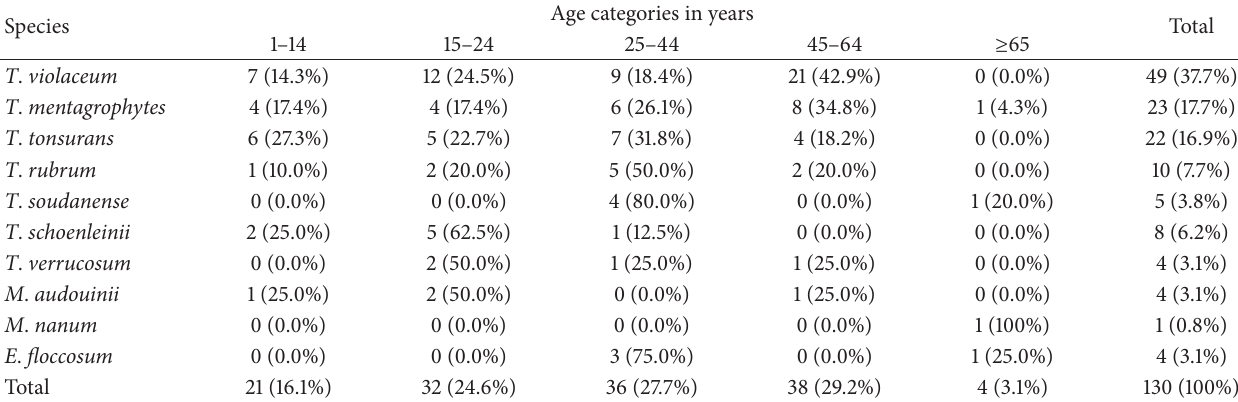
Table 4: Distribution of dermatophytes in relation to different age categories ( 𝑛 = 130).